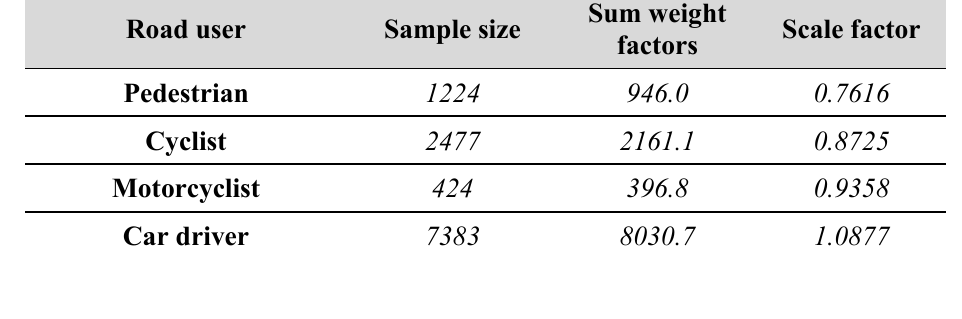
Table A2: Sample size, sum of weight factor and scale factor divided by the different road